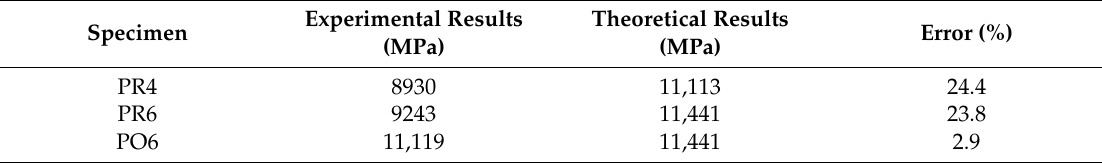
Table 4. MOE of the Cathay poplar glulam from the experimental tests and calculations.